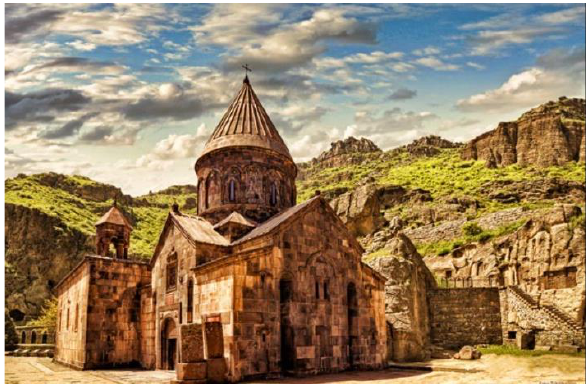
Figure 4. Monastery of Geghard and the Upper Azat